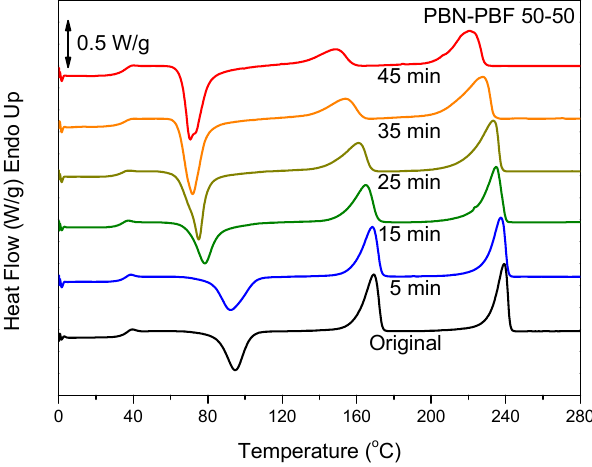
Figure 6. DSC traces of the melt-quenched PBN–PBF 50/50 samples after reactive blending for the indicated times.